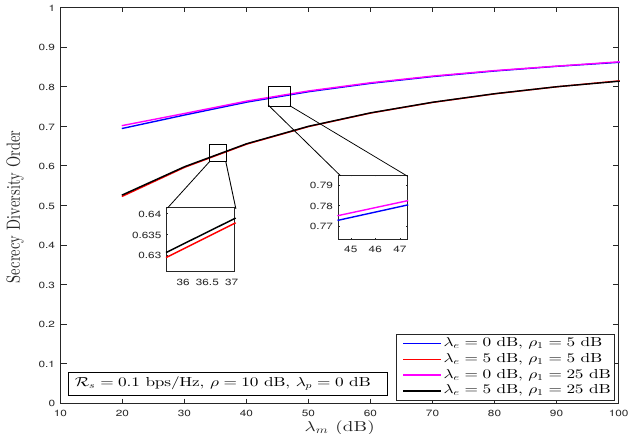
Figure 4. System’s secrecy diversity order behavior under Strategy II for λ m → ∞ and fixed λ e . When λ m → ∞ and λ e →